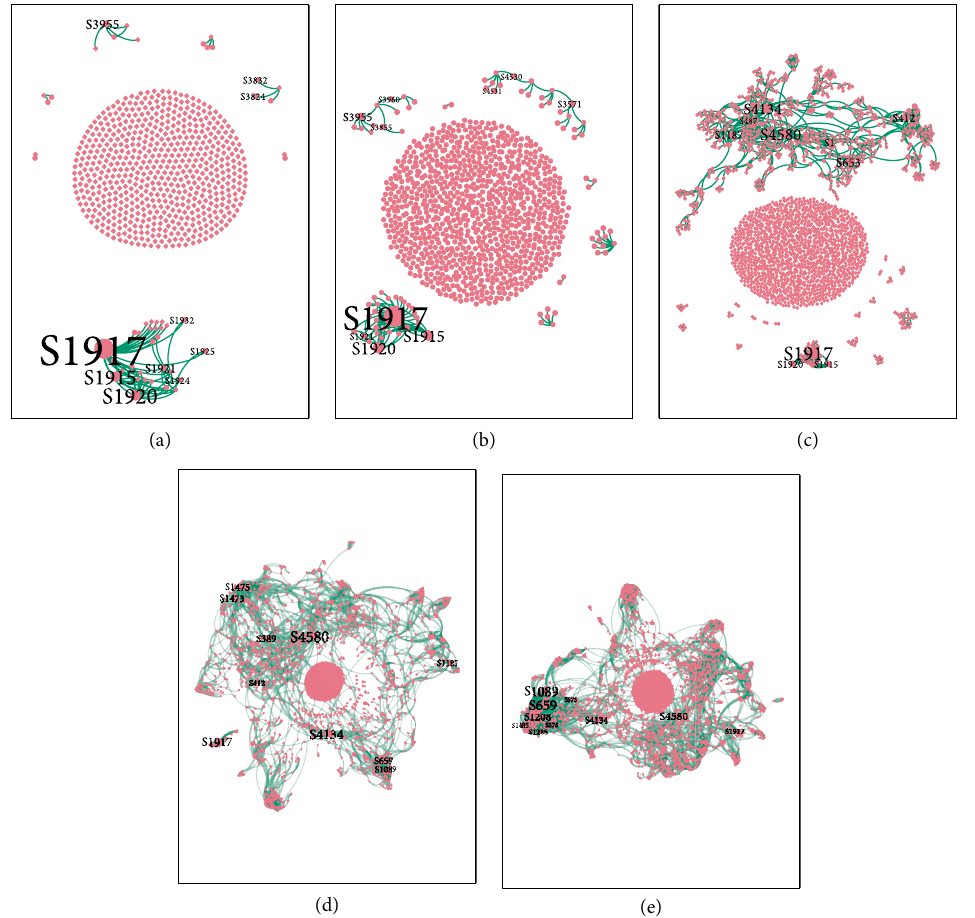
Figure 3: The sub-networks of citation in different stages. (a) 1997, (b) 2002, (c) 2007, (d) 2012, (e)